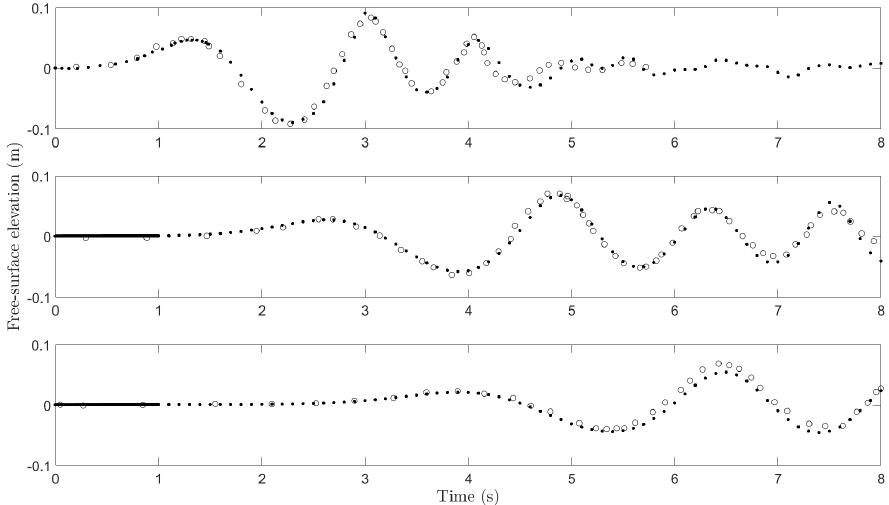
Figure 5. Reproduction of submarine landslide generated waves: records of free surface elevation at fixed locations (Top to bottom: x = 4,8,12 m). Dot: model predictions. Circle: measurements reported by Heinrich